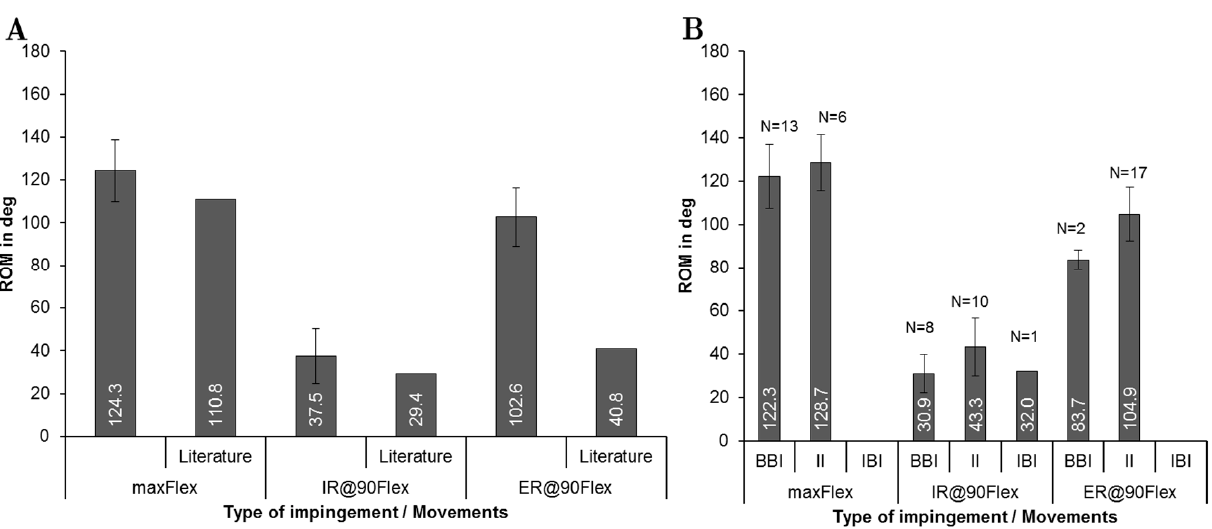
Figure 5. Comparison of the range of motion using implantation according to preoperatively planned situation for each patient (n = 19) during maximum flexion (maxFlex), internal rotation at 90 ◦ of flexion (IR@90Flex), and external rotation at 90 ◦ flexion (ER@90Flex). ( A ) Mean range of motion with standard deviations until impingement during the three movements. Physiological ROM are represented from literature studies for maxFlex and IR@90Flex [18,64], and ER@90Flex [54]. ( B ) Quantity N of impingement type (BBI, bone-to-bone-impingement; II, implant-to-implant-impingement; IBI, implant-to-bone-impingement).